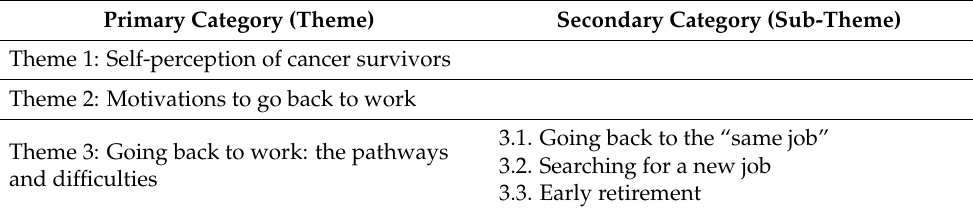
Table 1. Categories resulting from the content analysis of the